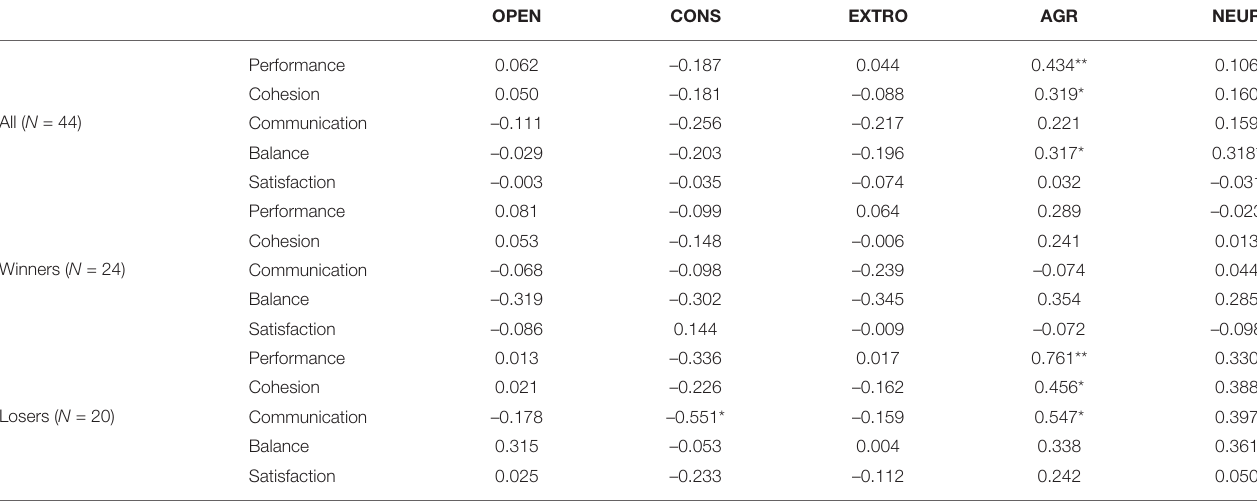
TABLE 9 | Correlations between perceived collaboration quality metrics and personality traits, ** p < 0.01, * p < 0.05.